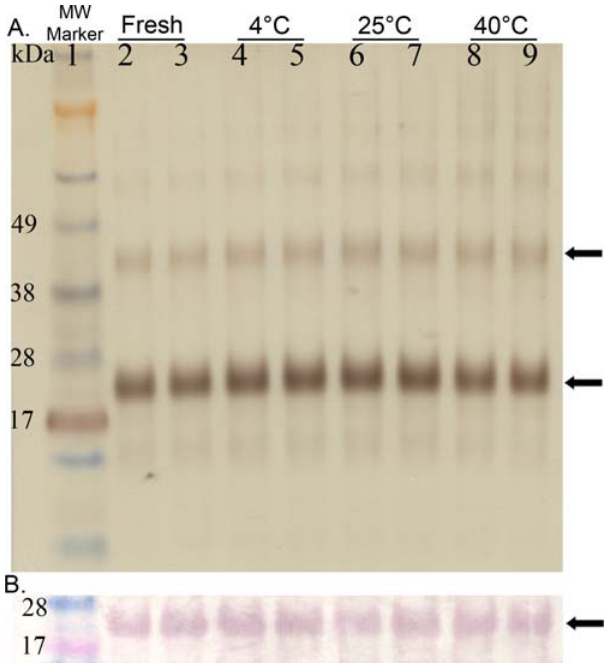
Figure 1. Stability of HBsAg. Silver stained SDS-PAGE: Analysis of freshly prepared vs. 72 hour incubated HBs antigen mixed with 20% NE (A). Conditions of the incubation are specified above the gel. HBsAg monomer and dimer are indicated with arrows at 24 kDa and 48 kDa bands. Western blot: The protein configuration is identical to as described for SDS-PAGE (B). HBsAg is detected using a polyclonal anti- HBsAg antibody for all incubation conditions.